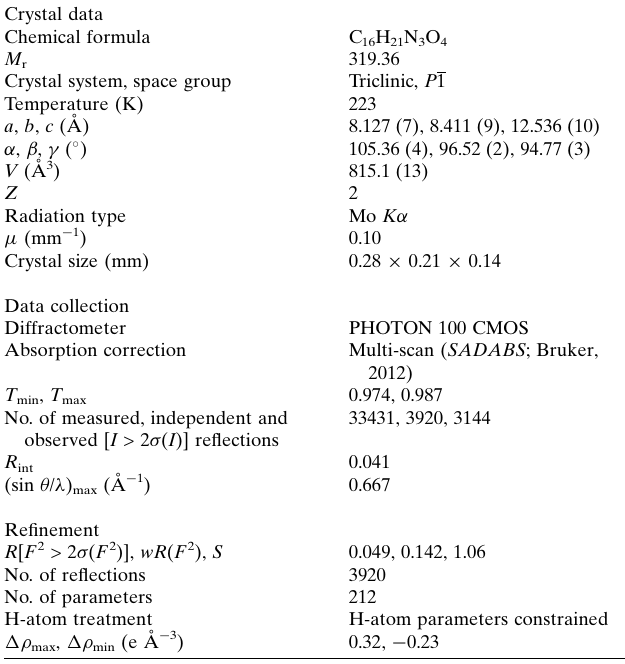
Table 2 Experimental details. Crystal data Chemical formula